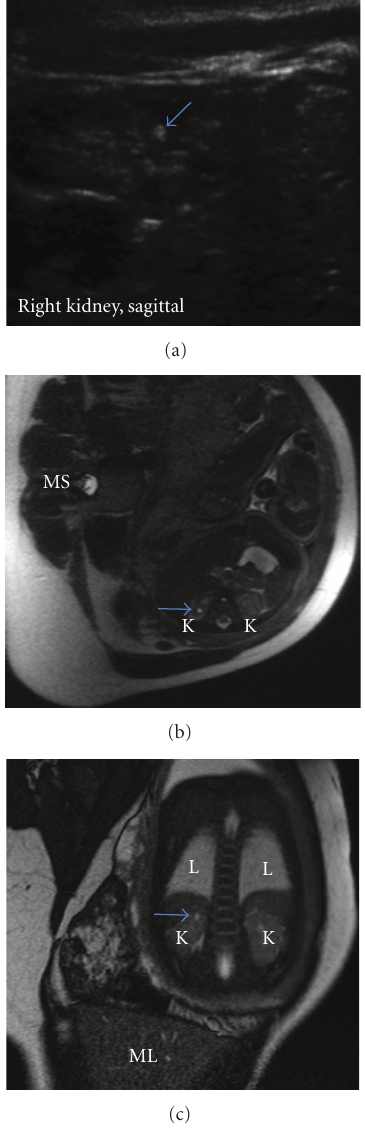
Figure 1: Multiple intracardiac masses (arrows) were detected on routine ultrasound (a), prompting a more thorough investigation. Fetal echocardiography ((b) and (c)) identified five masses that were within the ventricular myocardium although only two (arrows) can be seen in this plane. The masses were of uniform echogenicity and were more echogenic than the surrounding myocardium, consistent with the typical appearance of cardiac rhabdomyomas.